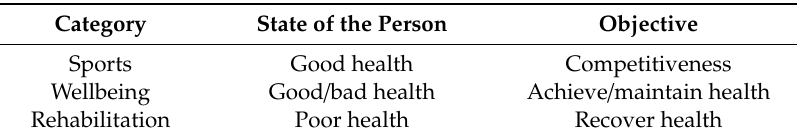
Table 1. Comparison of